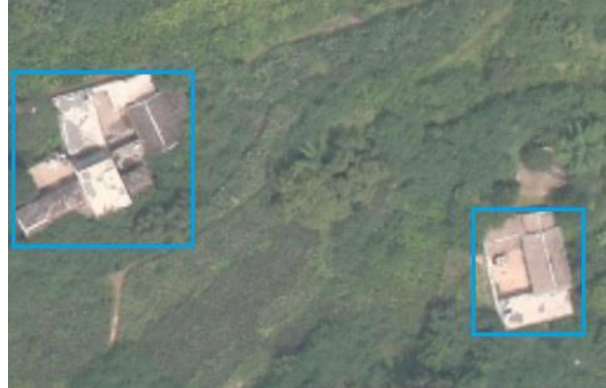
Figure 3. Labeling result of an image. Blue boxes indicate the real location of houses, and their information is recorded in a TXT file.